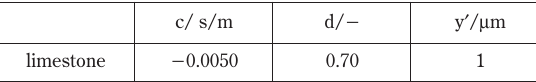
Table 2 Material parameters for the